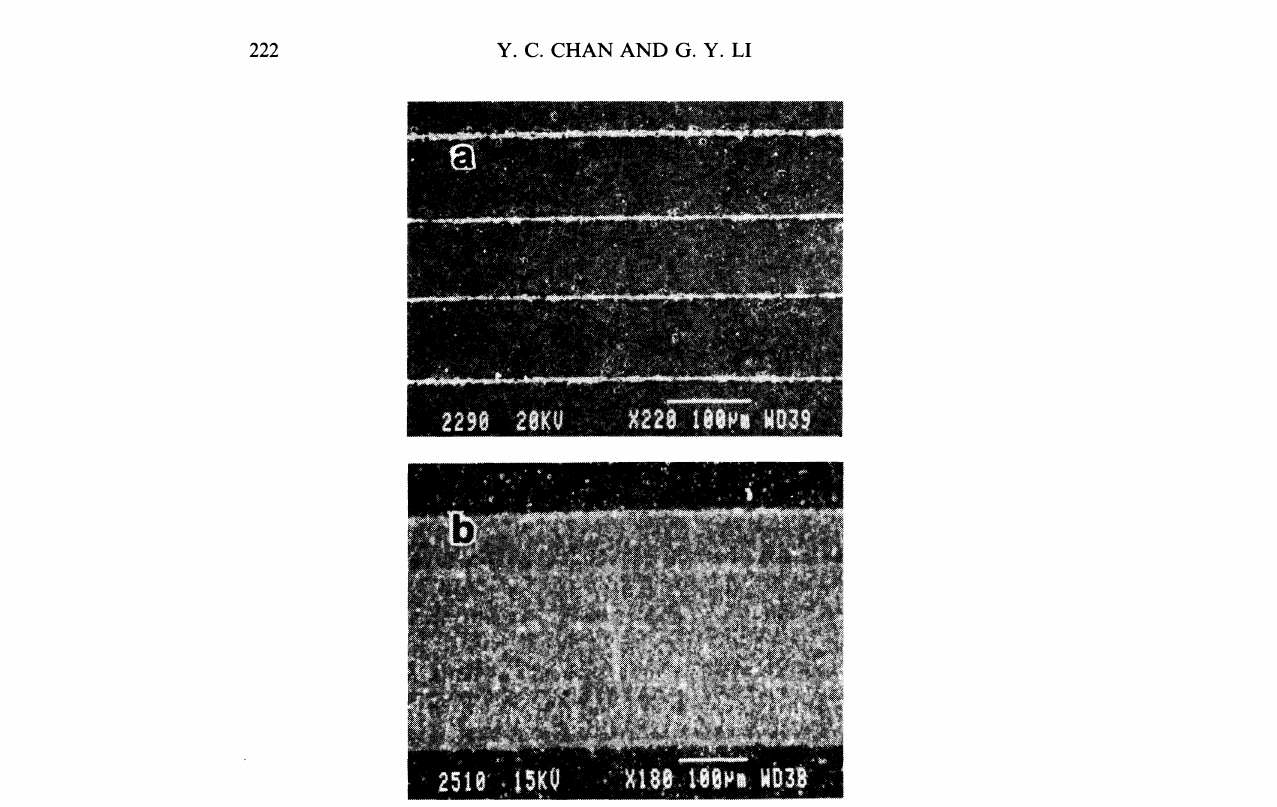
FIGURE 5 Microstructure of cross sections of embedded capacitors: a) low-value embedded capacitor; b) High-value embedded capacitor: the dark regions above and below are the low K substrate, the dark region between is the high K dielectric layer.